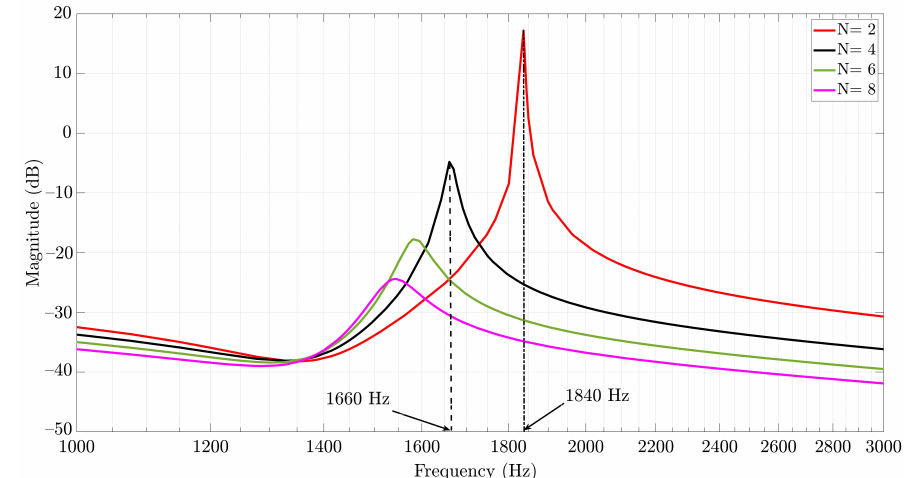
Figure 12. Grid voltage current resonance between the parallel VSIs and the utility